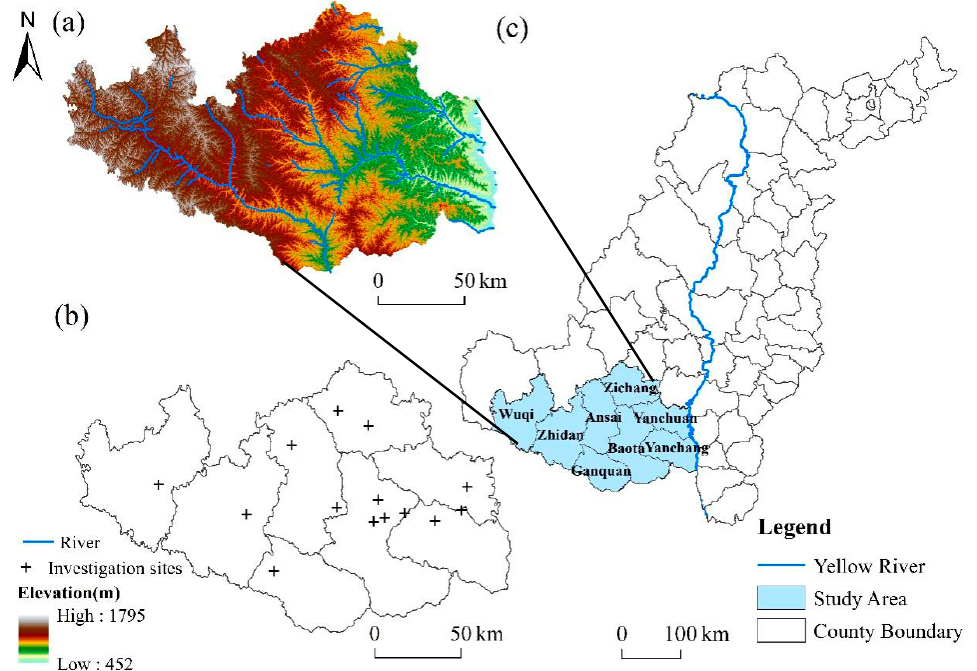
Figure 2. Location and investigation sites of the study area. ( a ) shows the digital elevation map of the study area, ( b ) shows the distribution of investigation sites in the study area, and ( c ) shows the loess hilly and gully region.